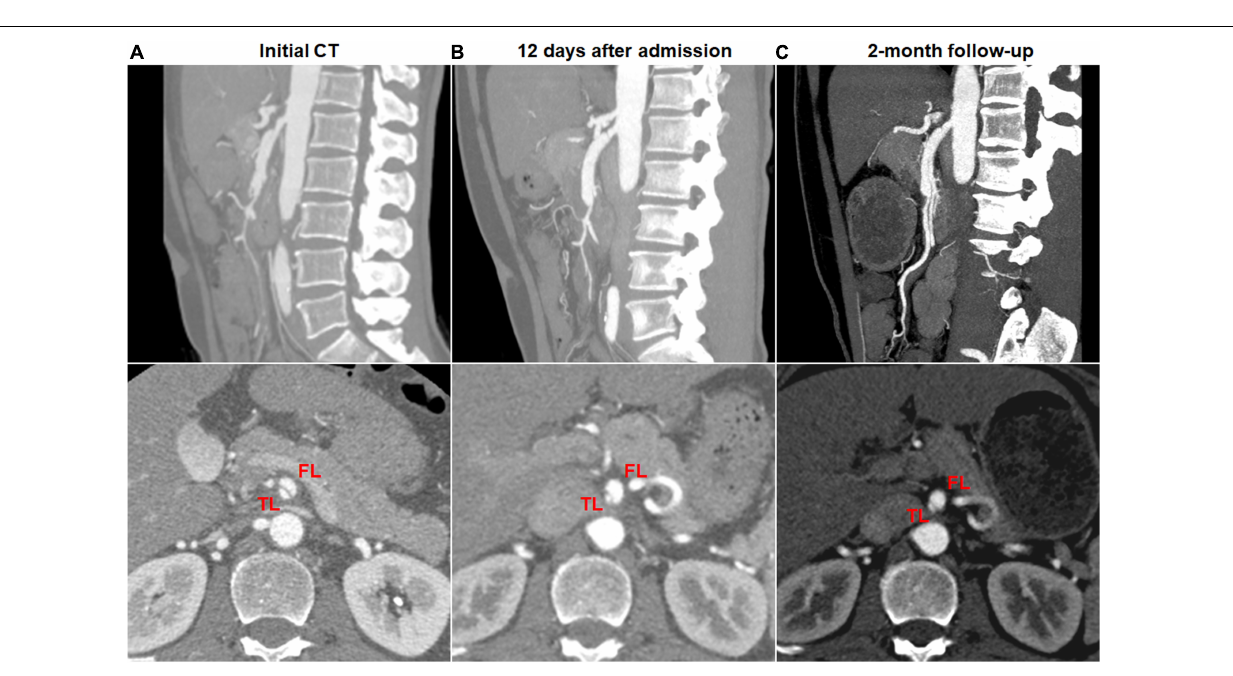
Frontiers in Cardiovascular Medicine |